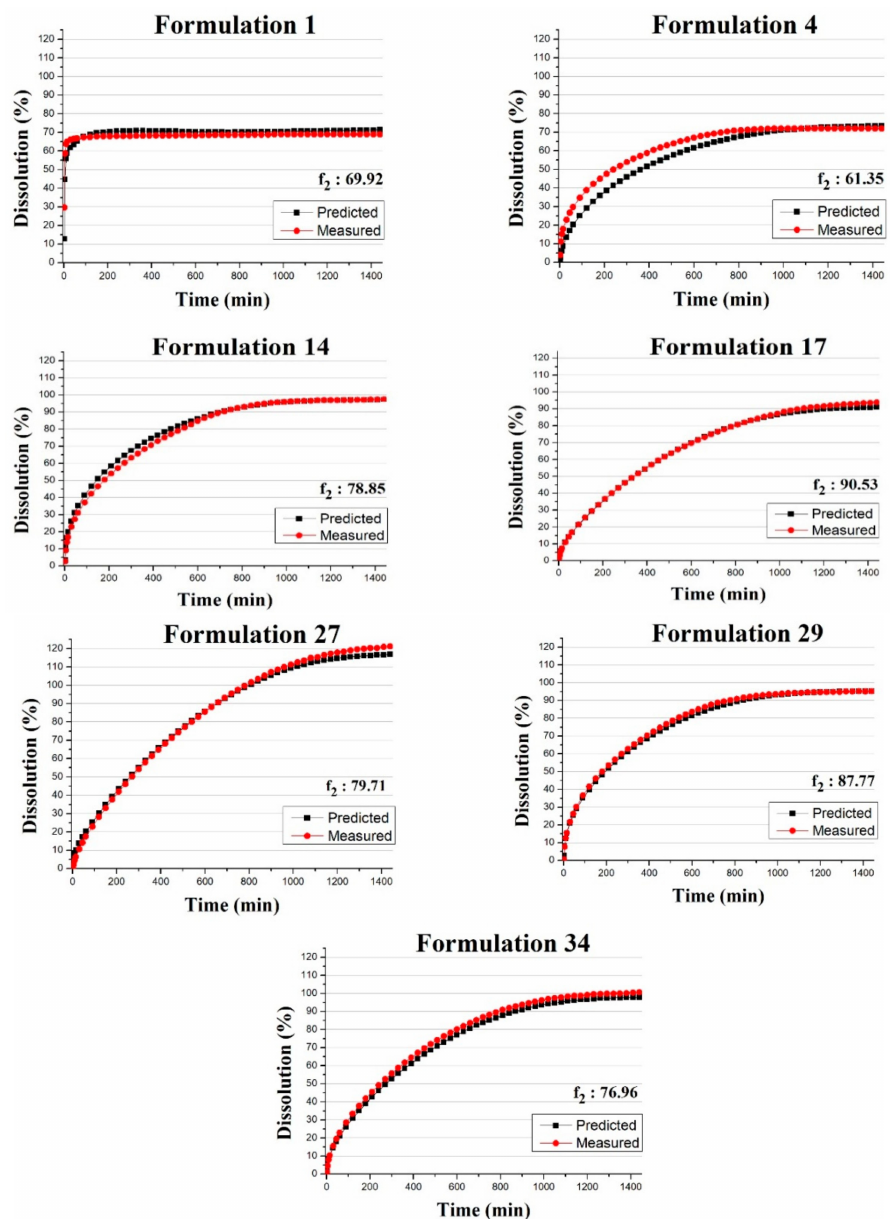
Figure 9. Average of predicted and measured dissolution profiles of validation tablets; inputs are based on Raman